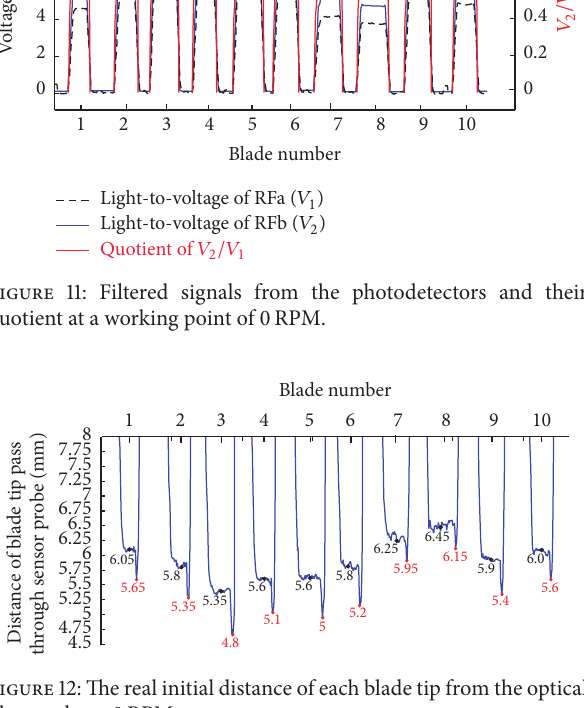
Figure 12: The real initial distance of each blade tip from the optical fiber probe at 0 RPM.